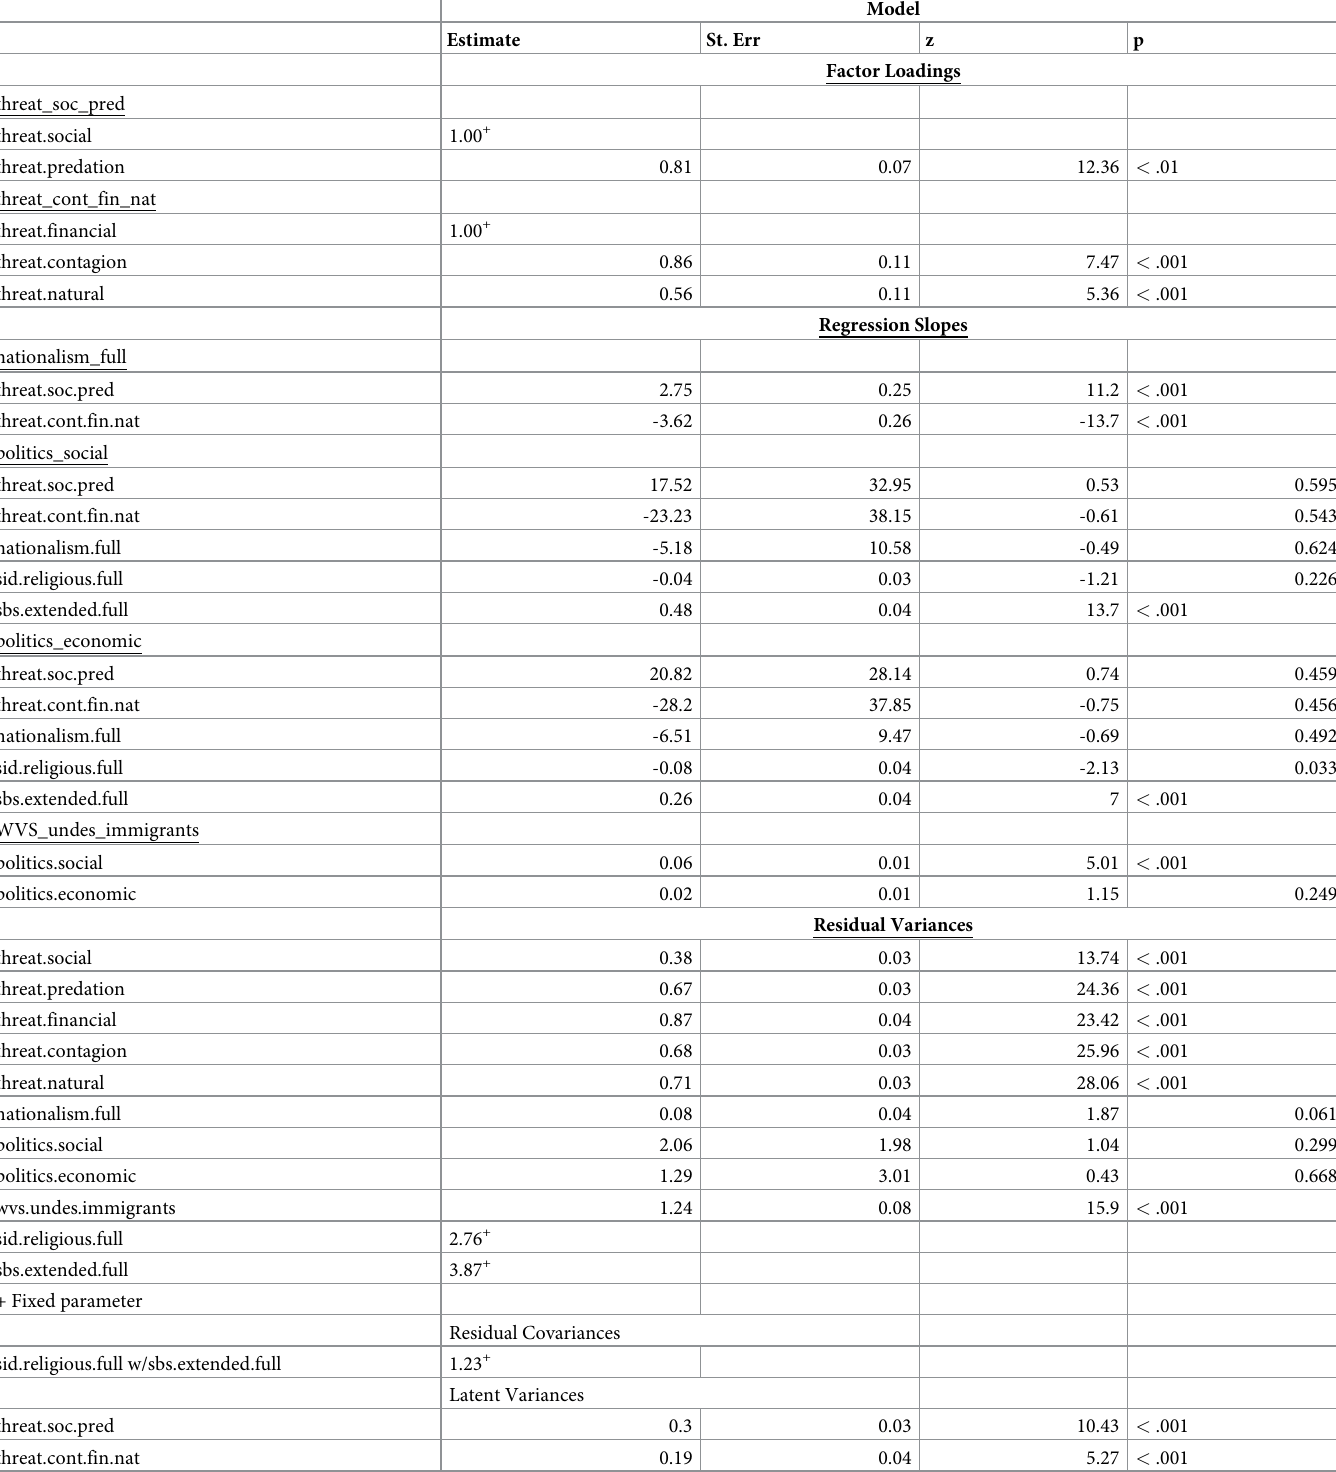
Table 7. a Factor loadings, regressions, and variances for the Structure Equation Model in Fig 12. b Residuals, latent variances and fit indices for the Structure Equa- tion Model in Fig 12. Model Estimate St. Err z p Factor